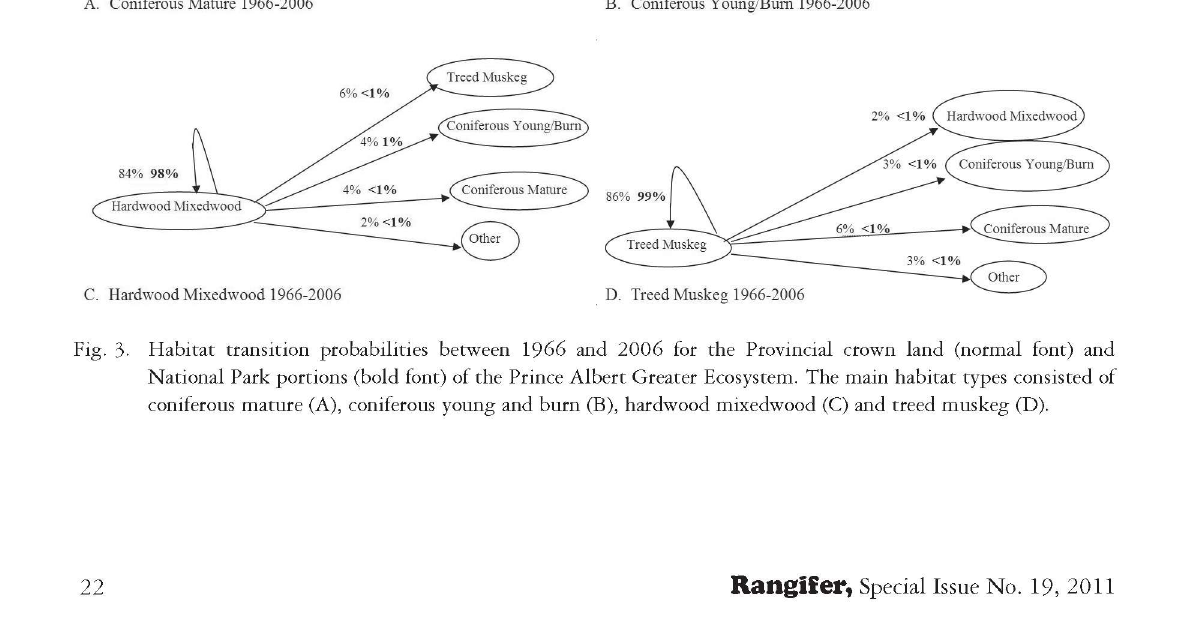
Rangifer, Special Issue No. 19,